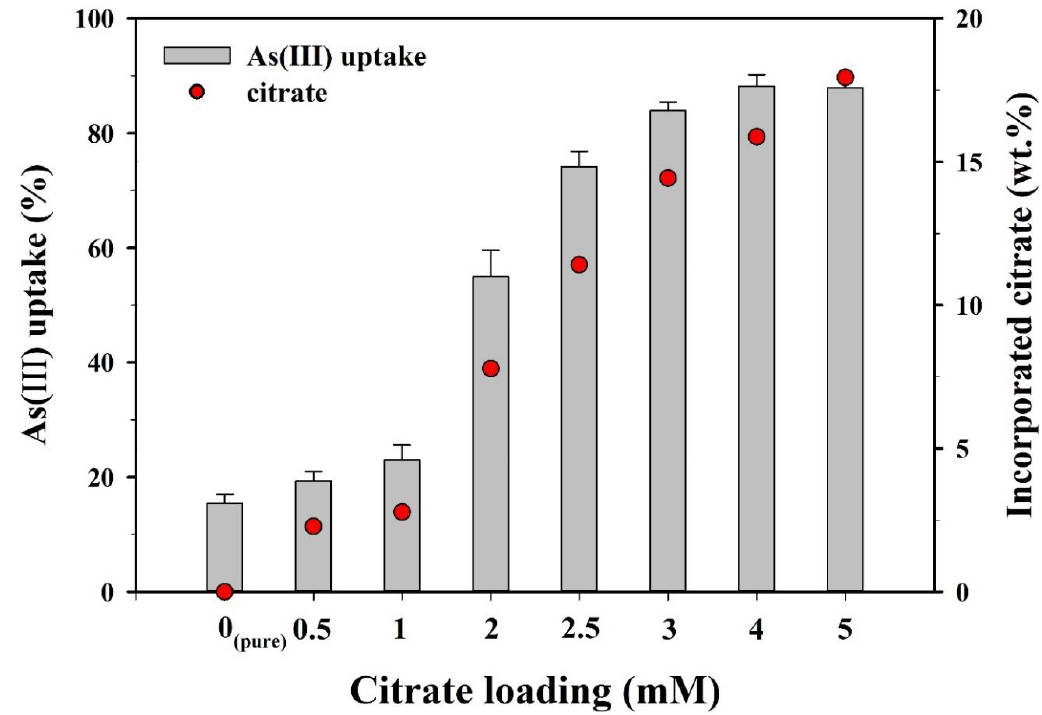
Figure 6. As(III) uptake by CF-NCs as a function of a loading rate of